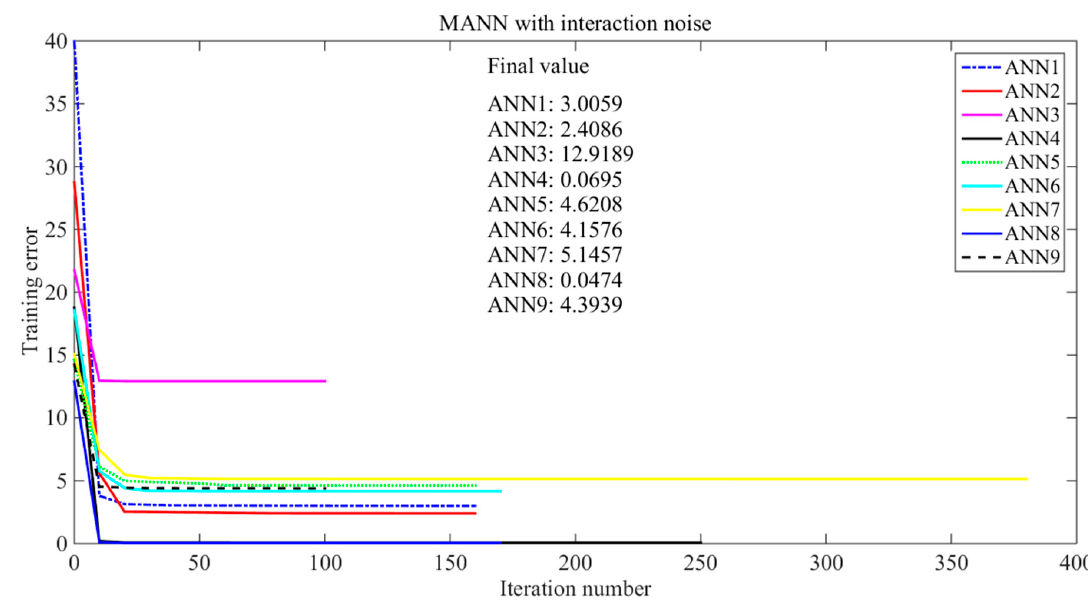
Figure 7. Training errors in the iteration process of MANN with interaction noise; different colors and line styles are used to distinguish the nine compositional ANNs.